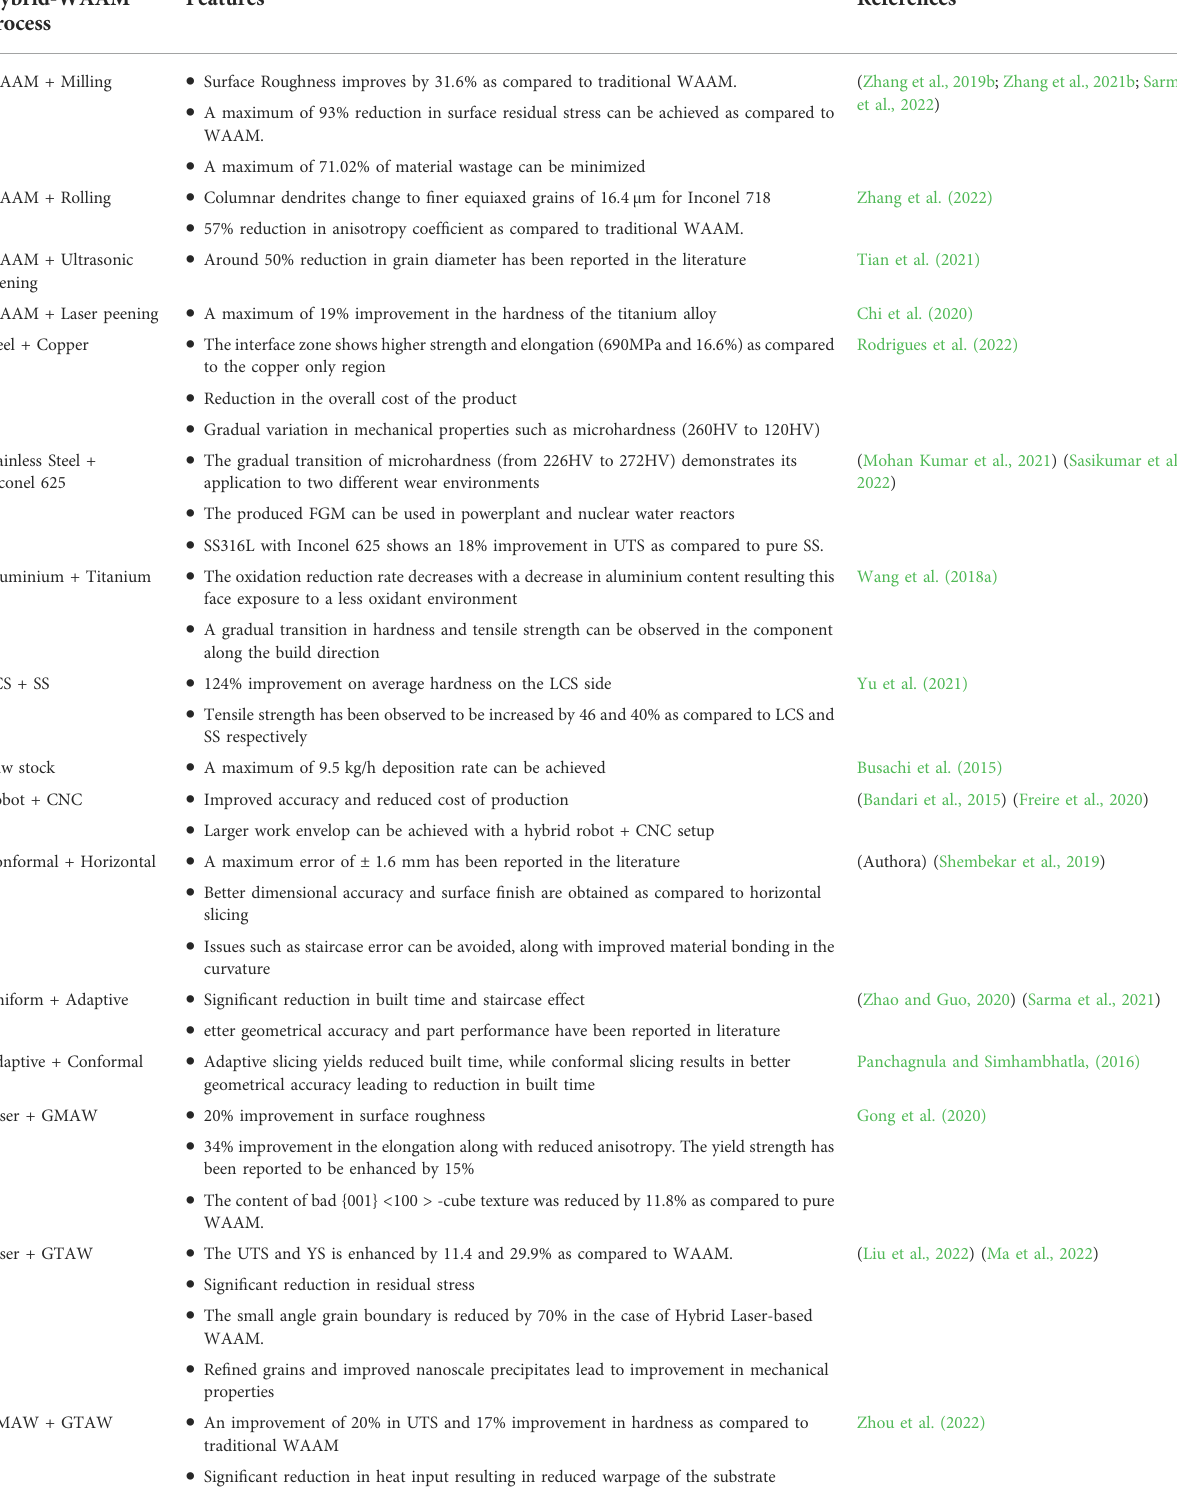
TABLE 2 Features associated with different Hybrid-WAAM